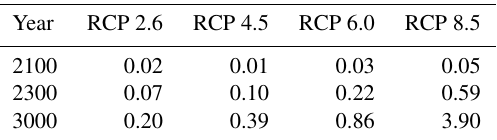
Table 2. Nominal projections (in metres) of AIS contribution to sea level on short-term (2100), medium-term (2300) and long-term (3000) timescales in different RCP